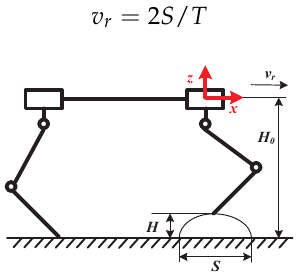
Figure 6. The illustration of the gait